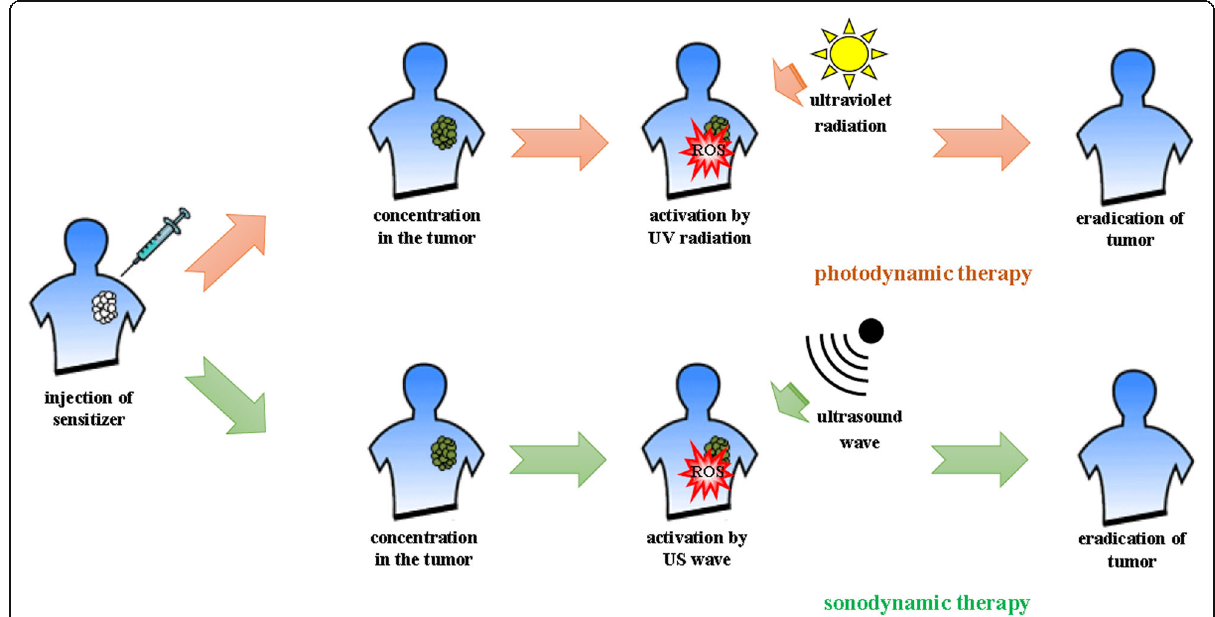
Fig. 2 Milestones of photodynamic therapy (PDT) and sonodynamic therapy (SDT) in tumor treatment. Cancer therapies, such as PDT or SDT, build on the administration of sensitive agents into tumor, followed by their activation by UV radiation or US wave, respectively. Activated photo- or sonosensitizers generate ROS that lead to cancer cell